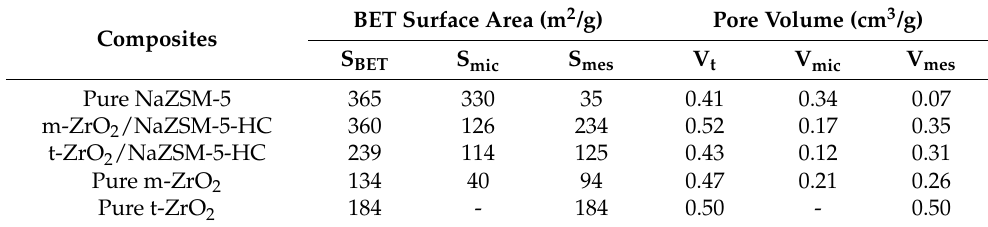
Table 2. Specific surface areas and pore structure parameters of different catalysts.